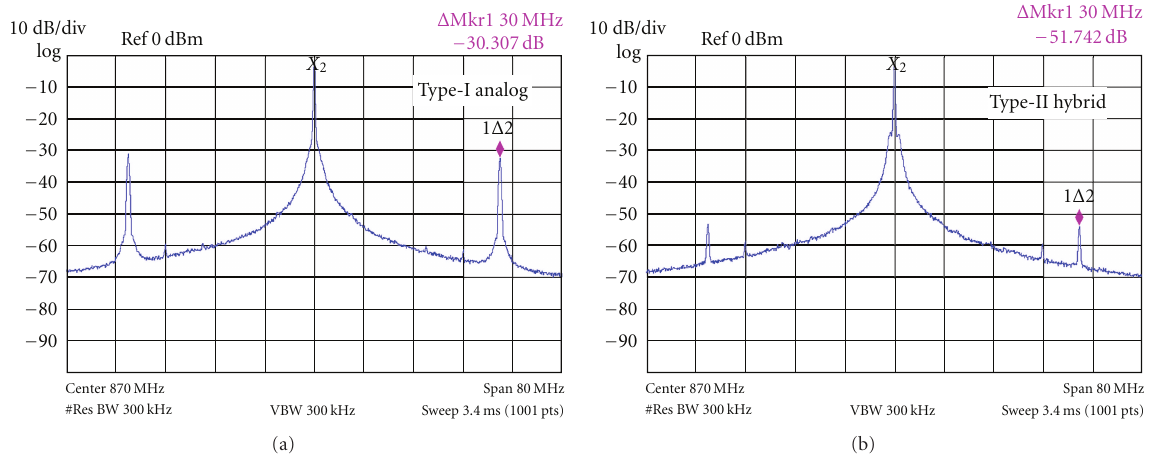
Figure 12: Measured output spectra: (a) with digital path disabled and (b) with digital path enabled.